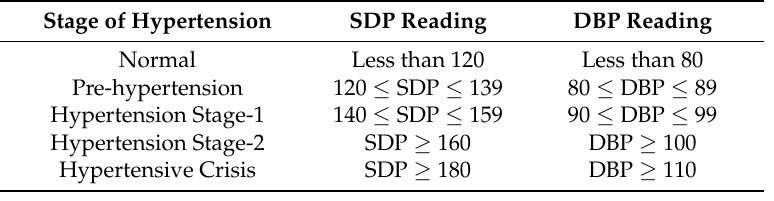
Table 2. Categorization of stages of hypertension.